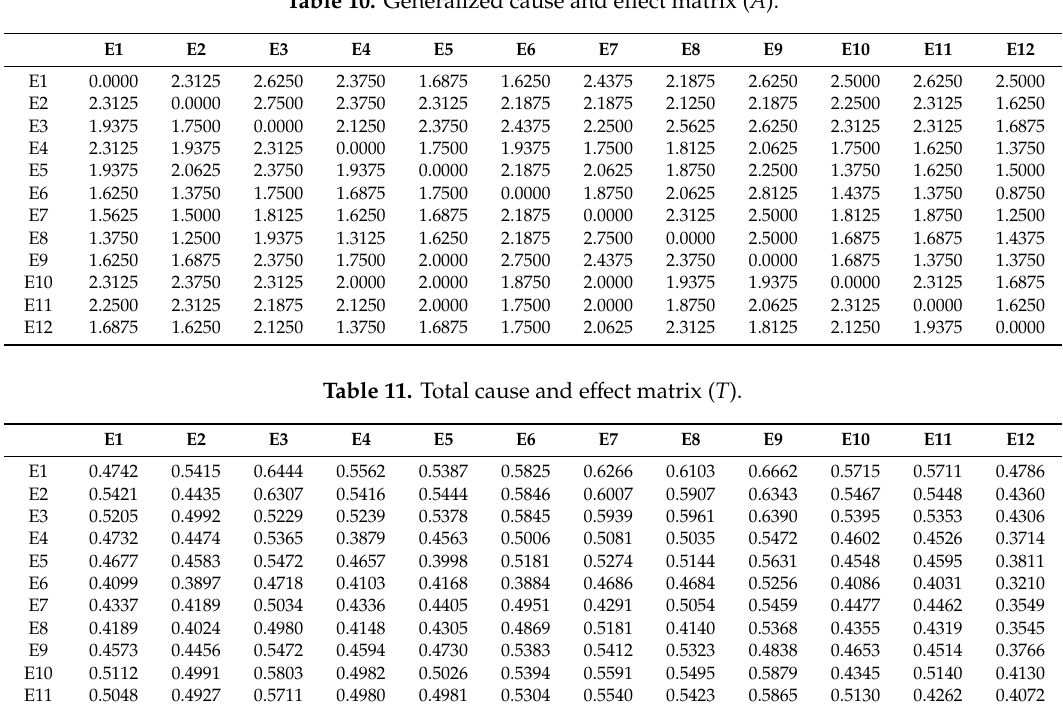
Table 10. Generalized cause and e ff ect matrix ( A ).